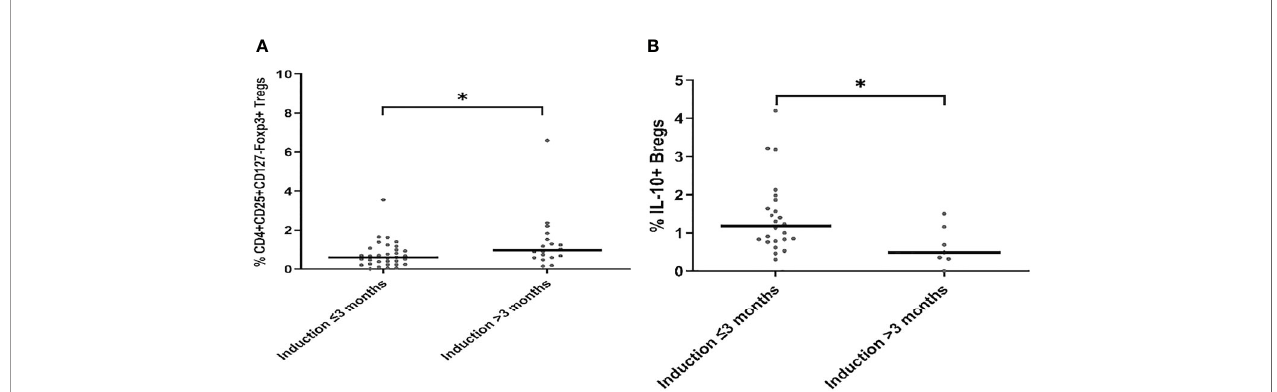
FIGURE 6 | Comparison of the absolute and relative counts of CD4+CD25+CD127-Foxp3+ Tregs (A) and CD19+IL-10+ Bregs (B) in early Tx recipients, in whom antibody induction dates back either ≤ 3 months or > 3 months prior to blood sampling. Medians were compared with Mann-Whitney test, *p < 0.05.